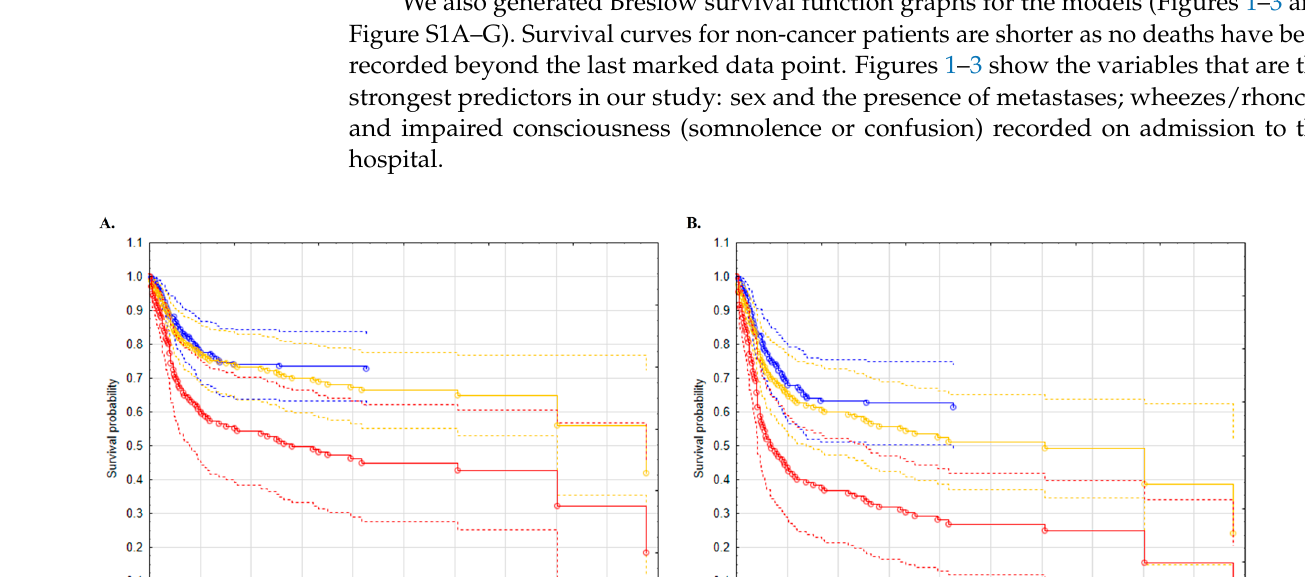
Figure 2. Survival analysis of patients with COVID-19 and impaired consciousness (somnolent/confu- sion) on admission to the hospital: ( A ) patients without cancer (blue); ( B ) patients with cancer (red).